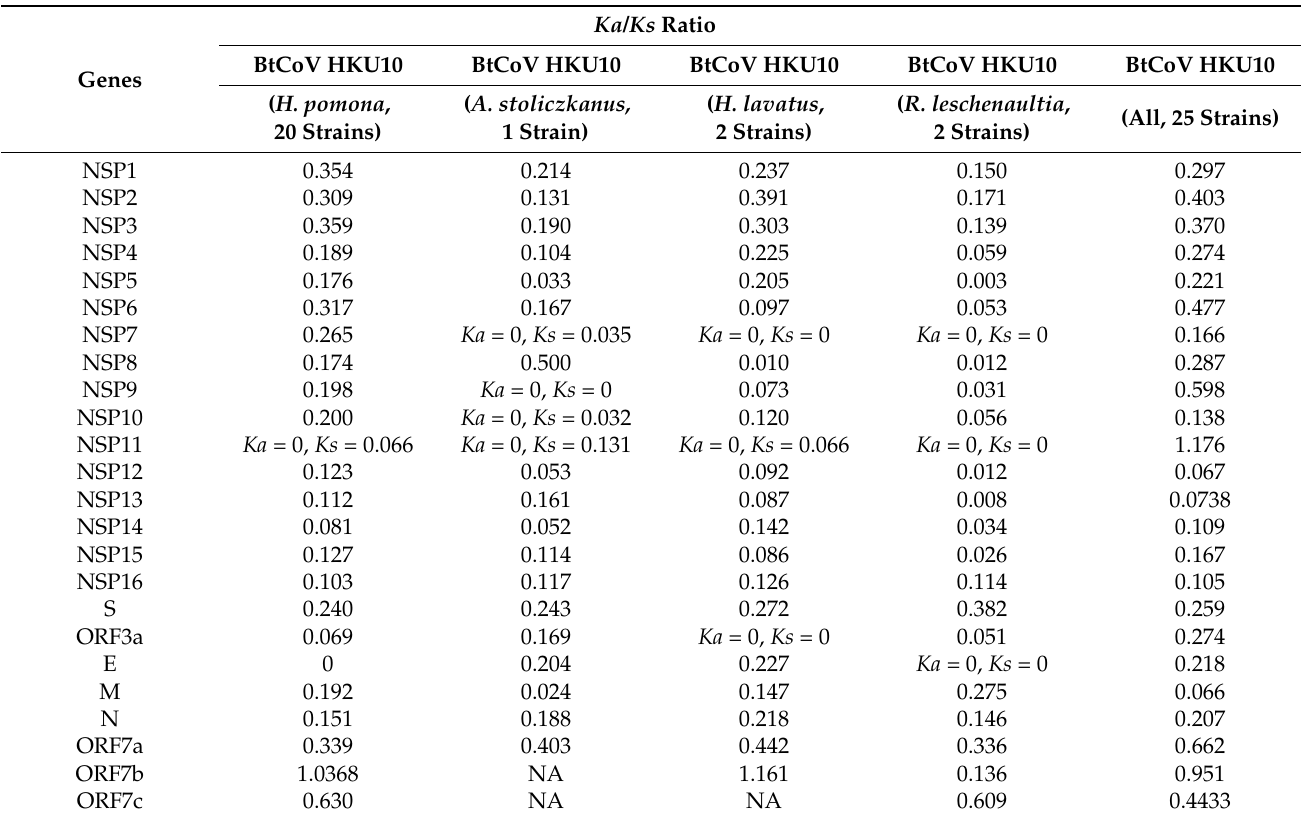
Table 2. Estimation of nonsynonymous and synonymous substitution rates in the genomes of BtCoV HKU10 in different host